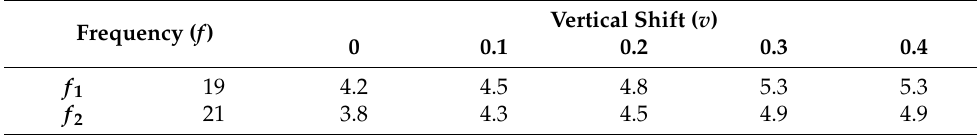
Table 3. Thickness of hollow bars (non-filled sections) in millimeters